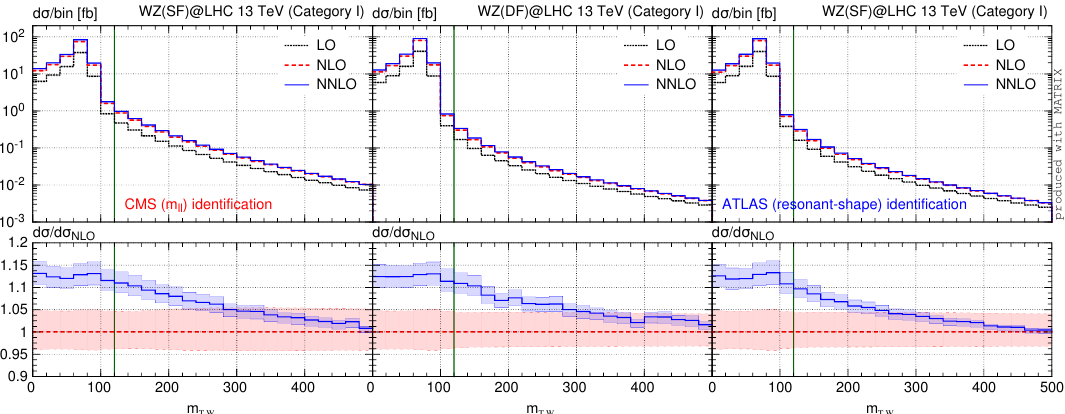
Figure 13 . Distributions with respect to m T;W in the (cid:12)ducial phase space without additional cuts (Category I); left: SF channel; centre: DF channel; right: SF channel, but using the resonant-shape identi(cid:12)cation of W and Z bosons as used by ATLAS. The green vertical line indicates the cut of m T;W > 120 GeV in Category